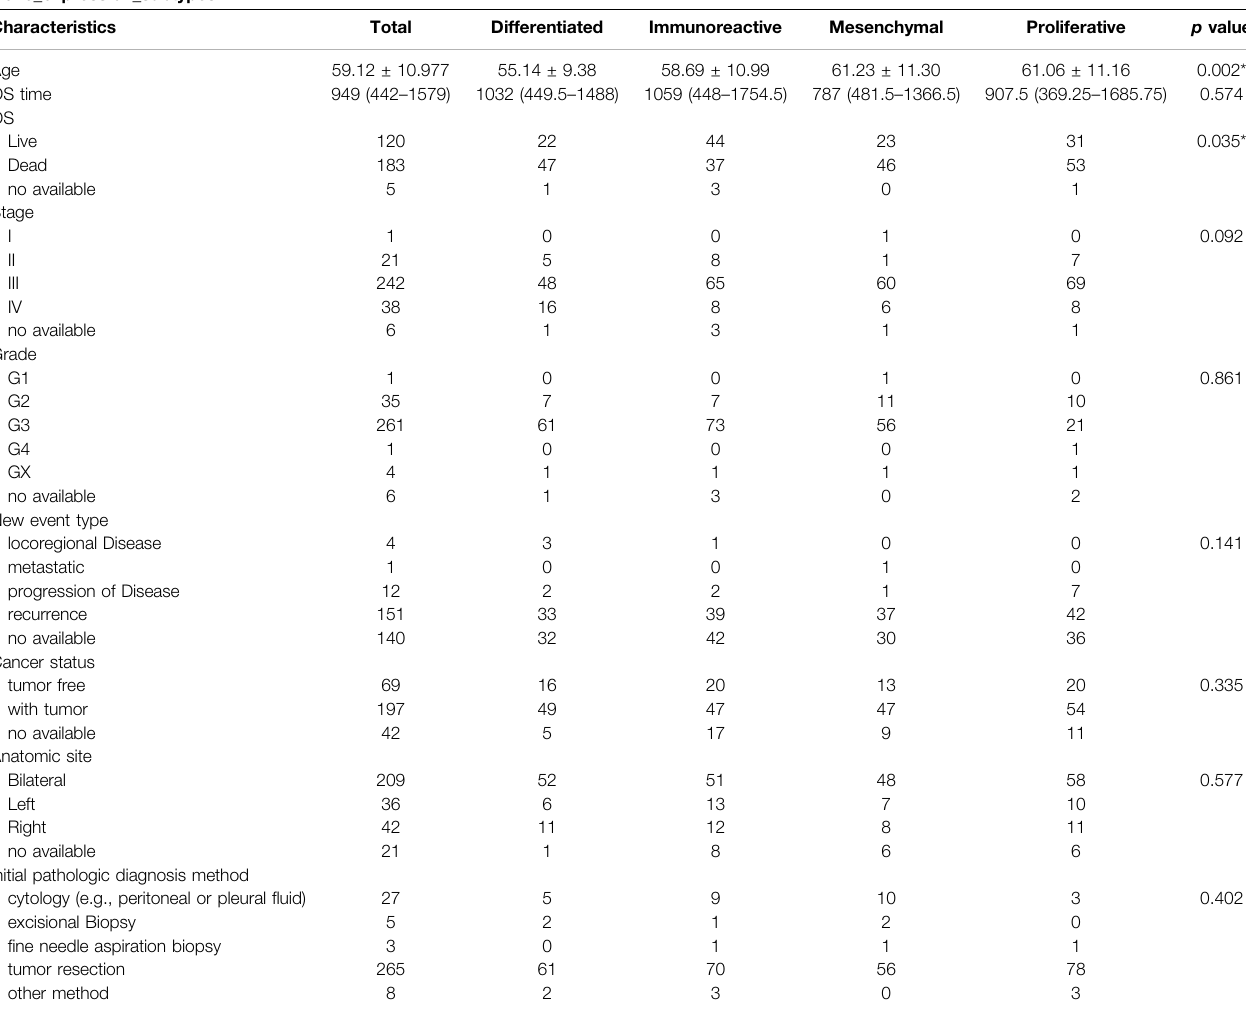
TABLE 2 | TCGA baseline clinical characteristics of gene expression subtypes and single-factor